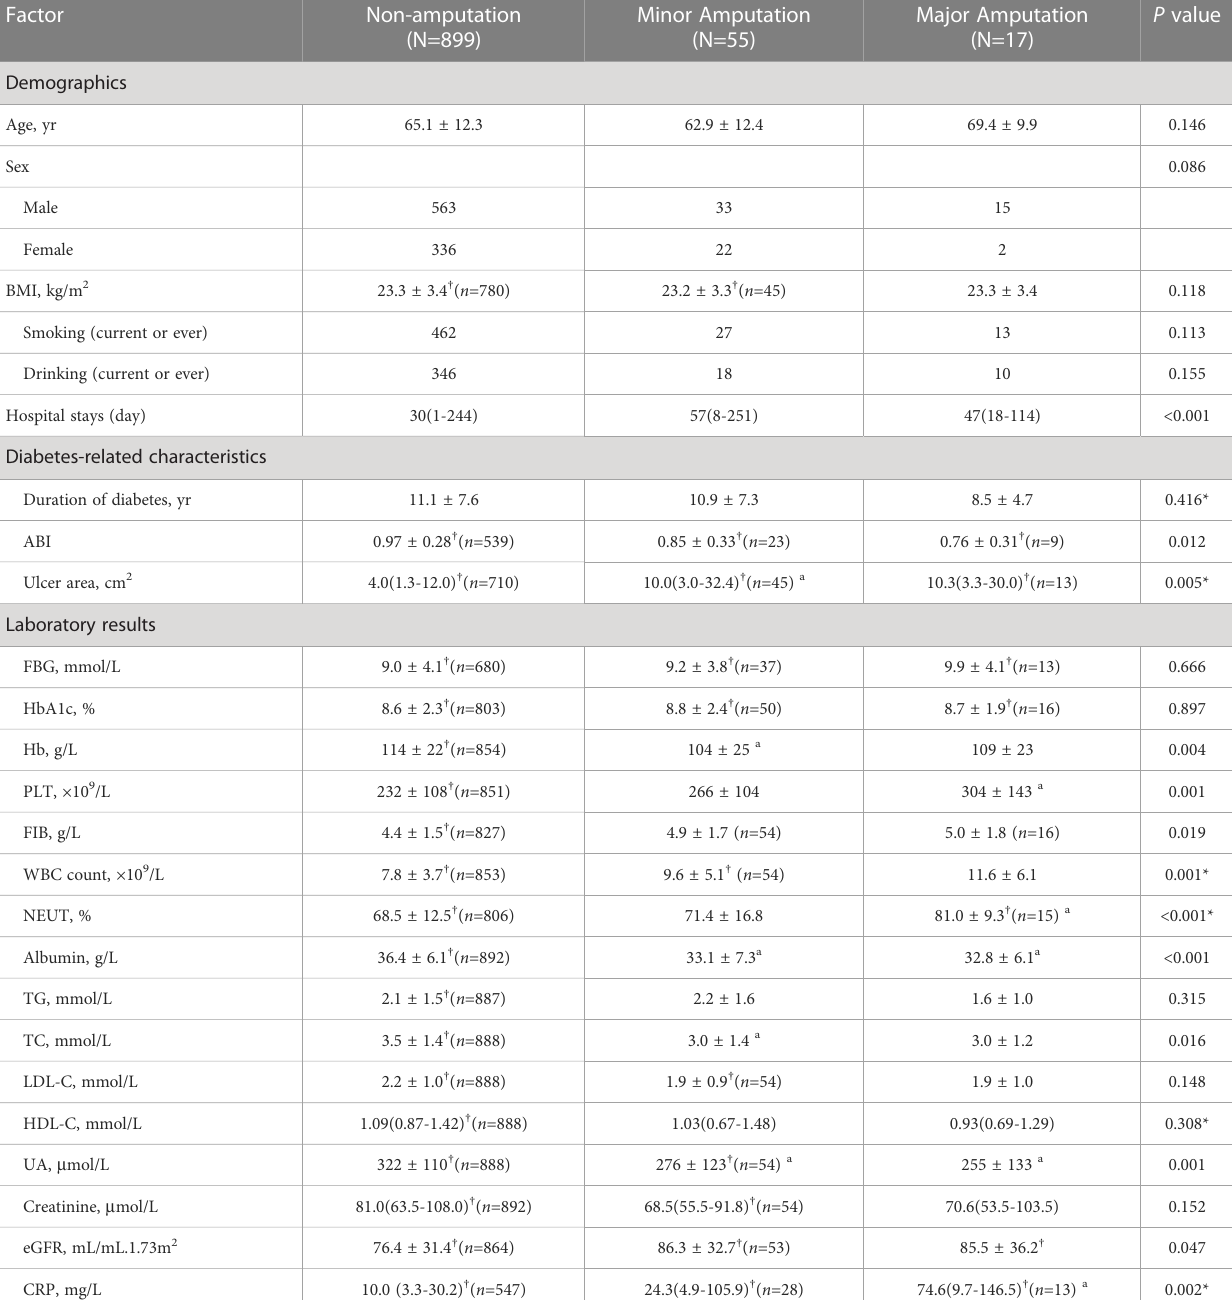
TABLE 1 Baseline demographic and laboratory data among the non-amputation, minor amputation and major amputation